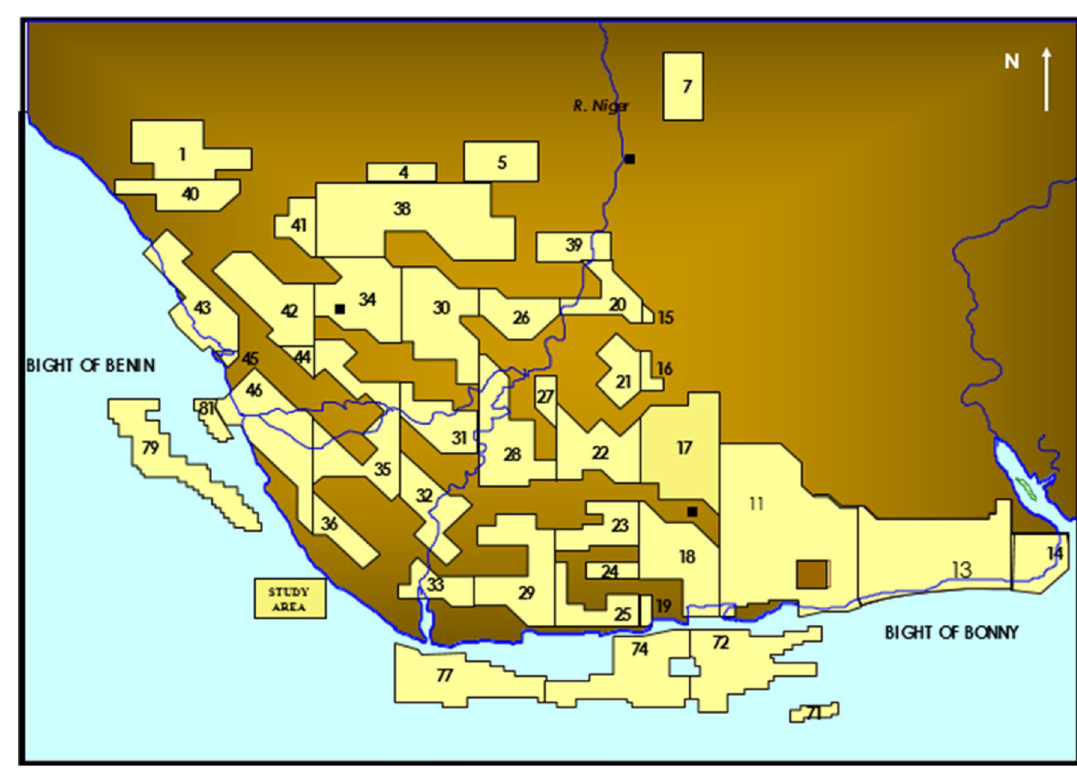
Fig. 2 Niger Delta concession map showing study area. Modified from Doust and Omatsola (1990) and Stacher